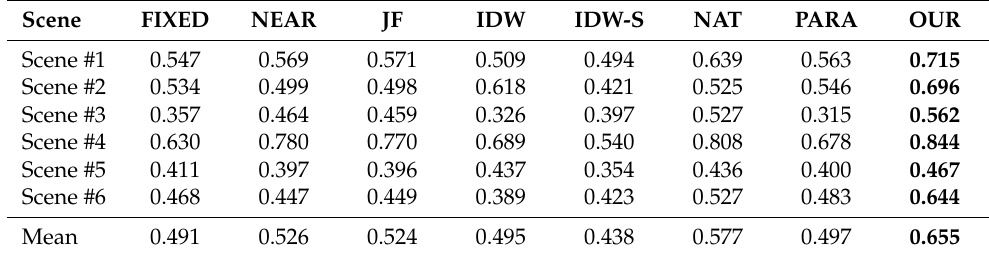
Table A3. SSIM scores of the presented approaches compared with our own approach. Higher score means higher similarity. The best results are highlighted in